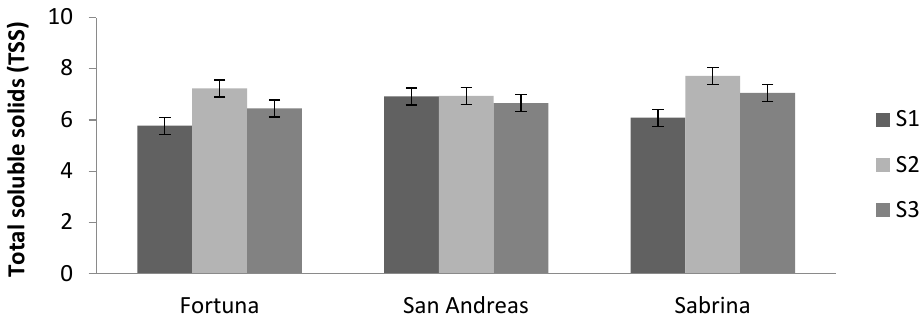
Figure 4. Mean values for total soluble solids for three strawberry cultivars (Fortuna, San Andreas and Sabrina) irrigated with three nutrient solutions. K:N balance: S1 (1.3/2.0), S2 (2.6/1.0), S3 (3.0/0.6) in growth and productive period. Vertical bars indicate LSD value ( p < 0.05).